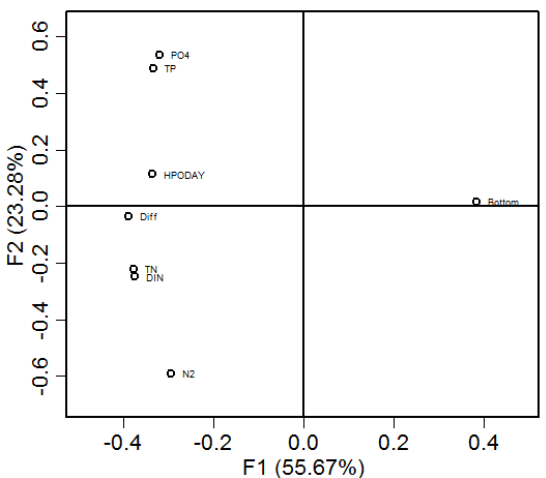
Figure 10. Principal Component analysis of daily hypoxia volume ( HPOV ) with nutrient loadings ( TN : Total nitrogen; TP : Total phosphorus; DIN : Dissolved inorganic nitrogen; PO4 : Phosphate), bottom saltwater intrusion distance ( Bottom ), difference between bottom and surface saltwater intrusion distances ( Diff) and stratification ( N 2 ).